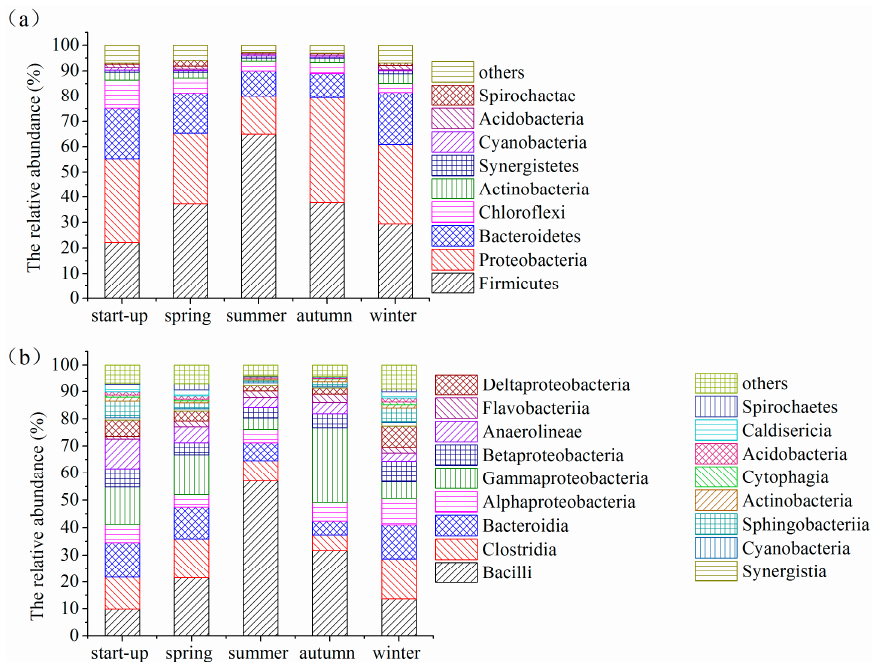
Figure 9. Bacterial community shifts at ( a ) phylum and ( b ) class level.